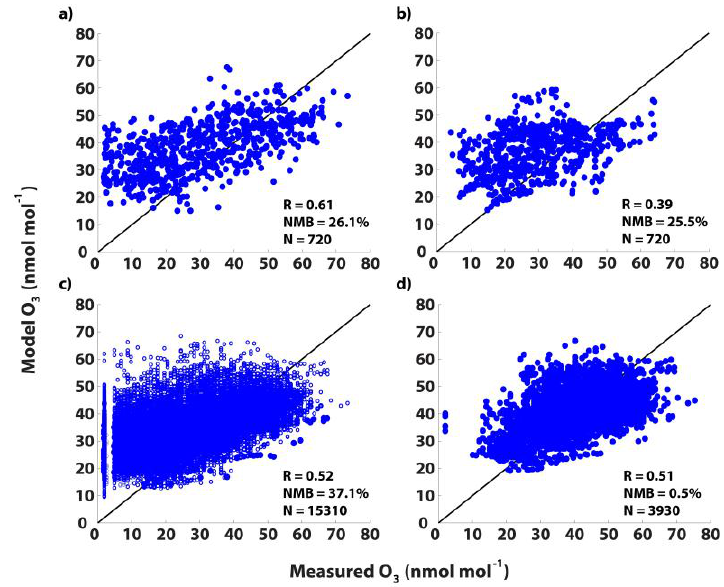
Figure 3. Comparison of surface-level hourly-averaged GEOS-Chem-predicted O 3 and observations (nmol mol − 1 ) from the SEARCH Networks located in ( a ) Birmingham, Alabama (BHM); ( b ) Centreville, Alabama (CTR); ( c ) all EPA AQS stations in Alabama (1–24 UTC); and ( d ) all EPA AQS stations in Alabama (17–22 UTC).